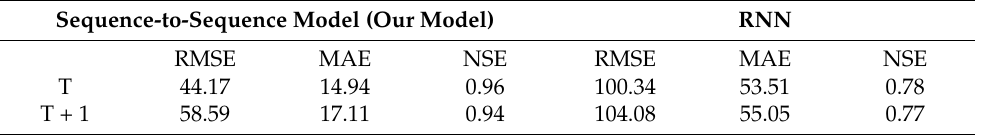
Table 16. Prediction accuracy results of our proposed model and the